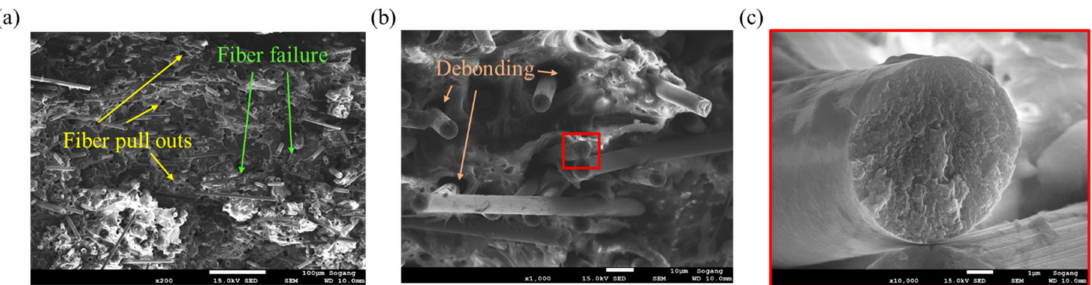
Figure 10. Fracture mechanisms observed for θ = 0 ◦ tensile specimen: ( a ) Fiber failure and fiber pull- outs (magnification: × 200, scale: 100 µ m), ( b ) fiber-matrix debonding (magnification: × 1000, scale: 10 µ m), ( c ) fracture face of the fiber after the tensile failure (magnification: × 10,000, scale: 1 µ